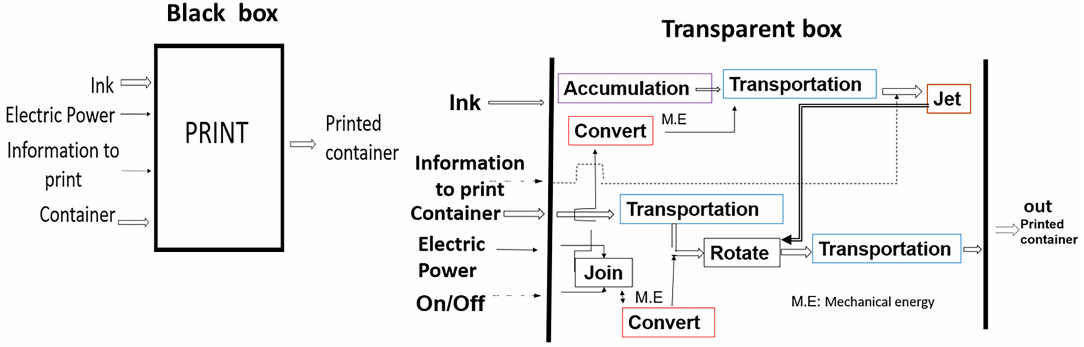
Figure 2. Black Box and Transparent